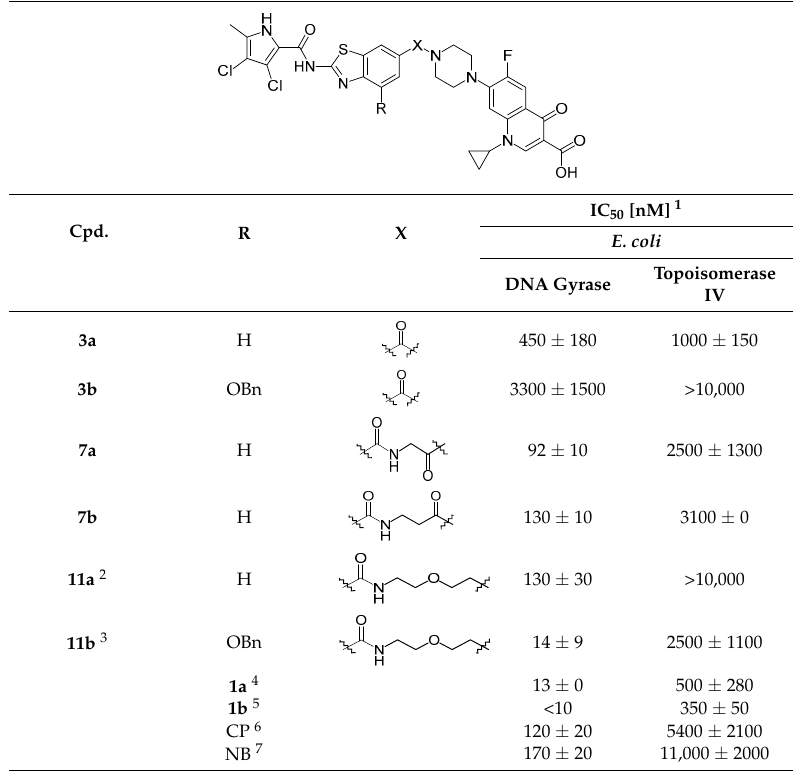
Table 1. Inhibitory activities of the new hybrid compounds against E. coli DNA gyrase and topoi- somerase IV.